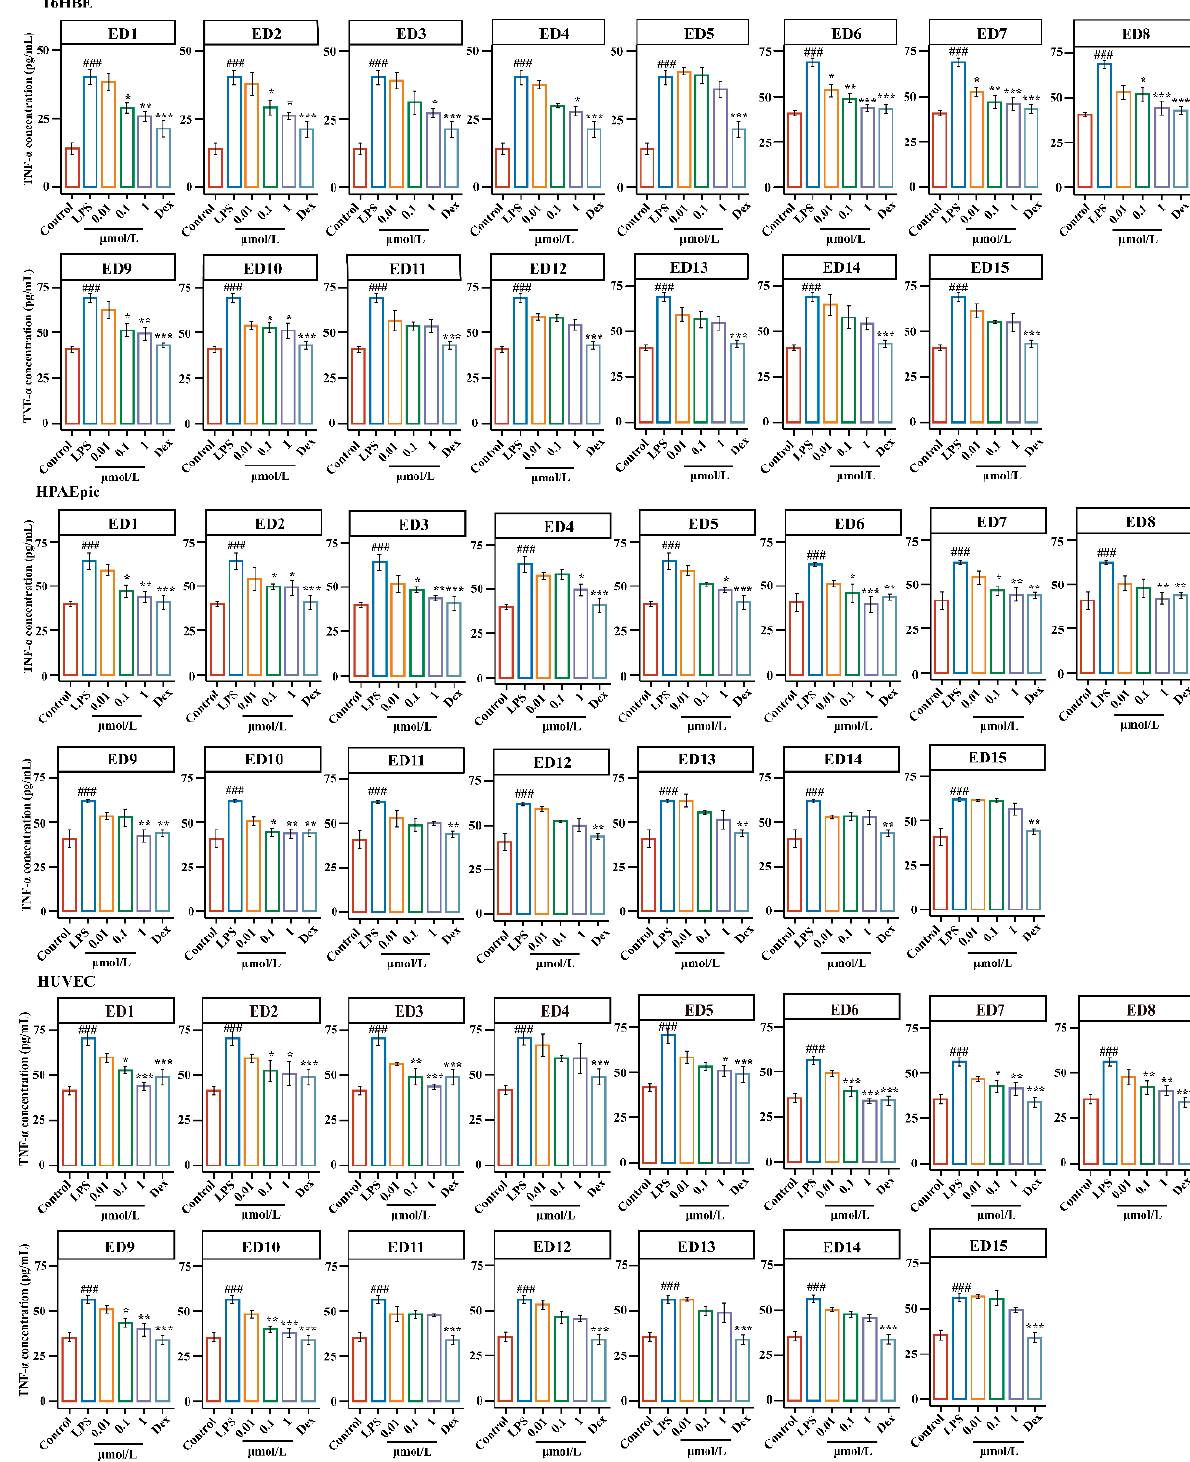
Figure 5. Effects of ED1-DE15 on TNF- α levels in LPS-induced cell injury in target cells. The 16HBE, HPAEpiCs and HUVECs were pretreated with ED1–15 at the concentration of 0.01–1 µ M for 12 h. Dex was used as a positive control drug (5 µ g/mL). TNF- α levels in the medium, as measured by ELISA. Results were obtained from three independent experiments and are presented as mean ± SEM. ### p < 0.001 vs. Control; * p < 0.05, ** p < 0.01, *** p < 0.001 vs. LPS. LPS, Lipopolysaccharide; Dex, Dexamethasone.